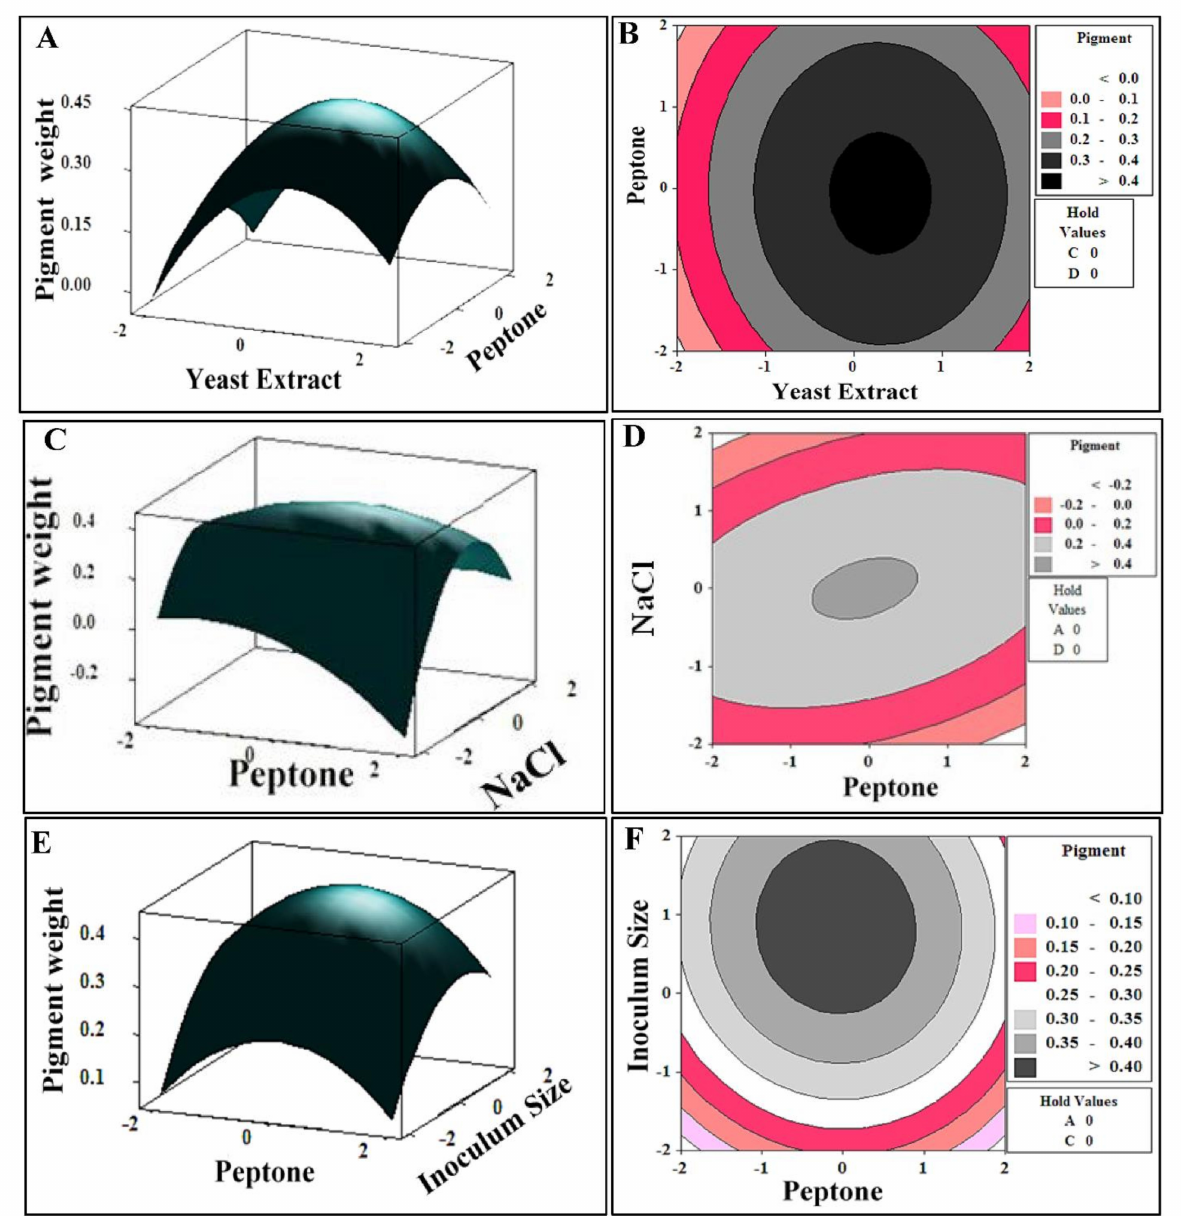
Figure 4. Three- dimensional surface plots ( left panels) and two-dimensional contour plots ( right panels) showing the interactive effects of independent significant variables on pigment